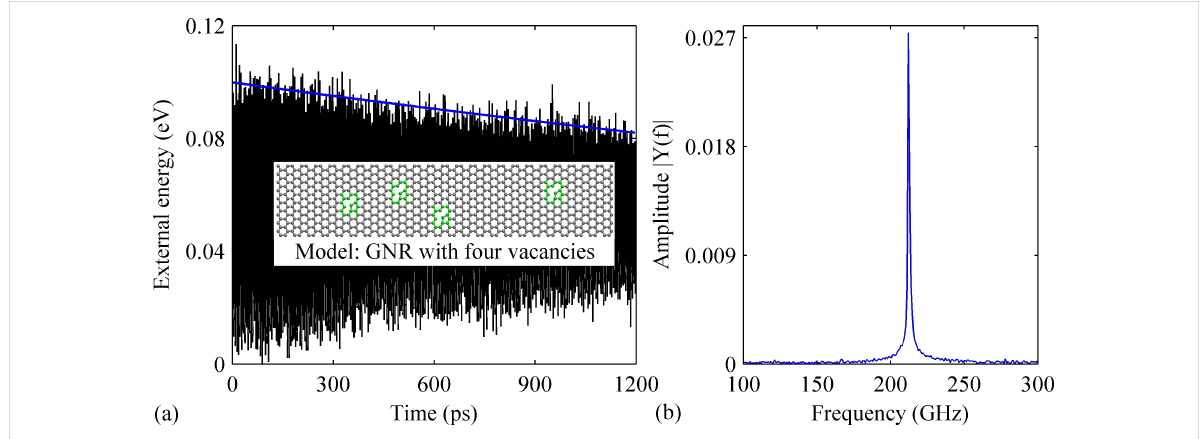
Figure 8: (a) Time history of the external energy obtained from pristine defective GNR with four vacancies. The inset shows the corresponding model of GNR with four vacancies. The regions highlighted in green represent the vacancies. (b) The corresponding frequency spectrum.